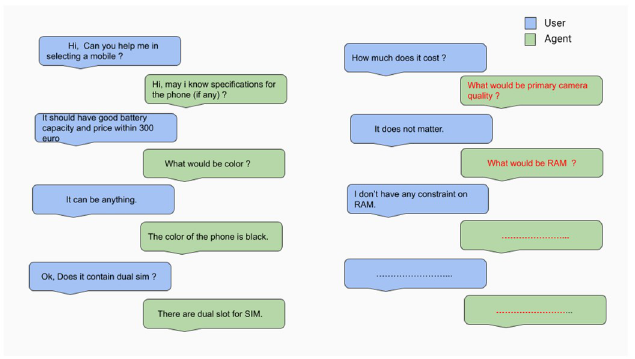
Fig 12. VA performance during testing—sample2.